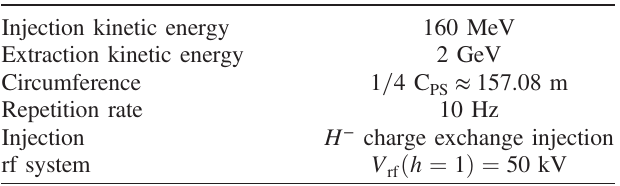
TABLE IV. Lattice and optics parameters used for